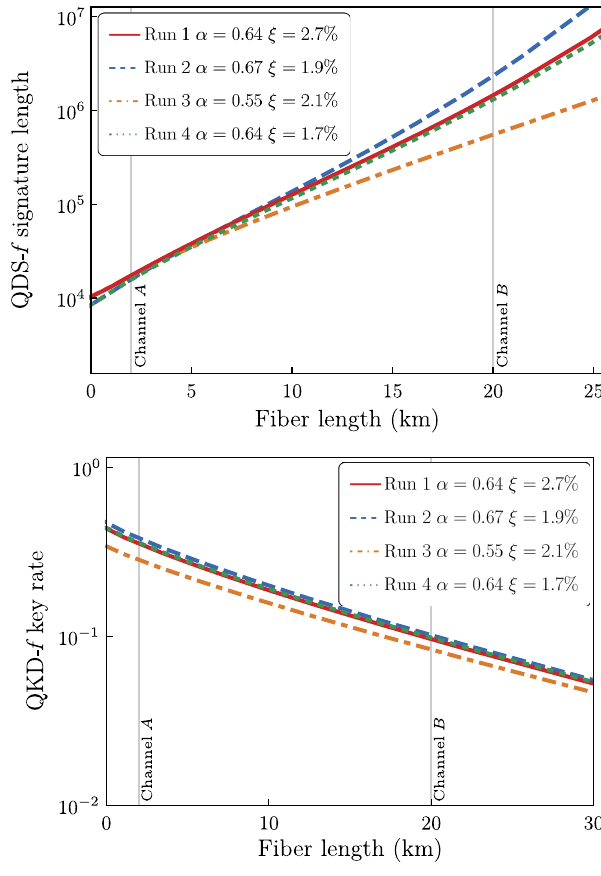
FIG. 7. Calculated performance of agile and versatile system QDS- f -QKD- f -CV-QPSK. Top: QDS signature lengths under protocol QDS- f under a beam-splitter attack. Signature lengths L at 20 km (channel B ) remain feasible with both ideal (above) and experimental realizations (Table I). At 2 km (channel A ), the protocol requires small signature lengths and thus is the fastest QDS protocol over comparable distances (Fig. 8). Bottom: calculated maximum QKD key rates under protocol QKD- f with a beam-splitter attack. Both: vertical grid lines denote channel losses at which we perform an experiment. Solid (red), dashed (blue), dot-dashed (orange), and dotted (green) lines correspond to experiments 1, 2, 3, and 4, respectively, and vertical grid lines depict loss levels over experimental channels A and B corresponding to fiber lengths 2 km (0.65-dB loss) and 20 km (4.75-dB